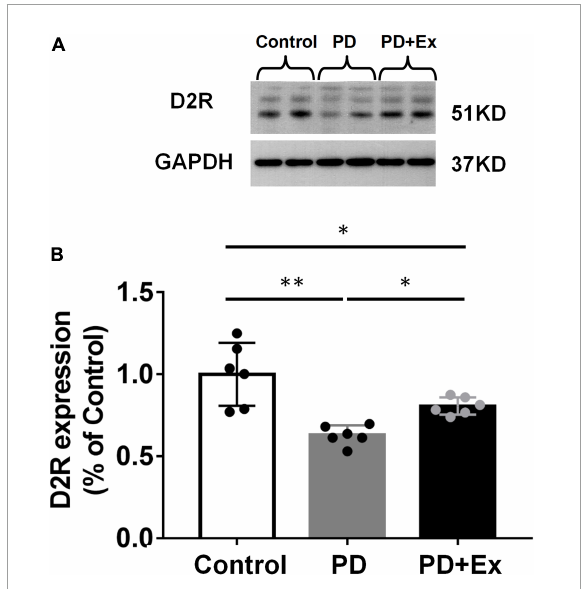
FIGURE7 Effect of exercise on the expression of striatal D2R in PD mice. (A) Striatum D2R protein expression western blot. (B) Striatum D2R expression in each group (one-way ANOVA, p < 0.05). All data are showed as mean ± SEM. ∗ p < 0.05, ∗∗ p <